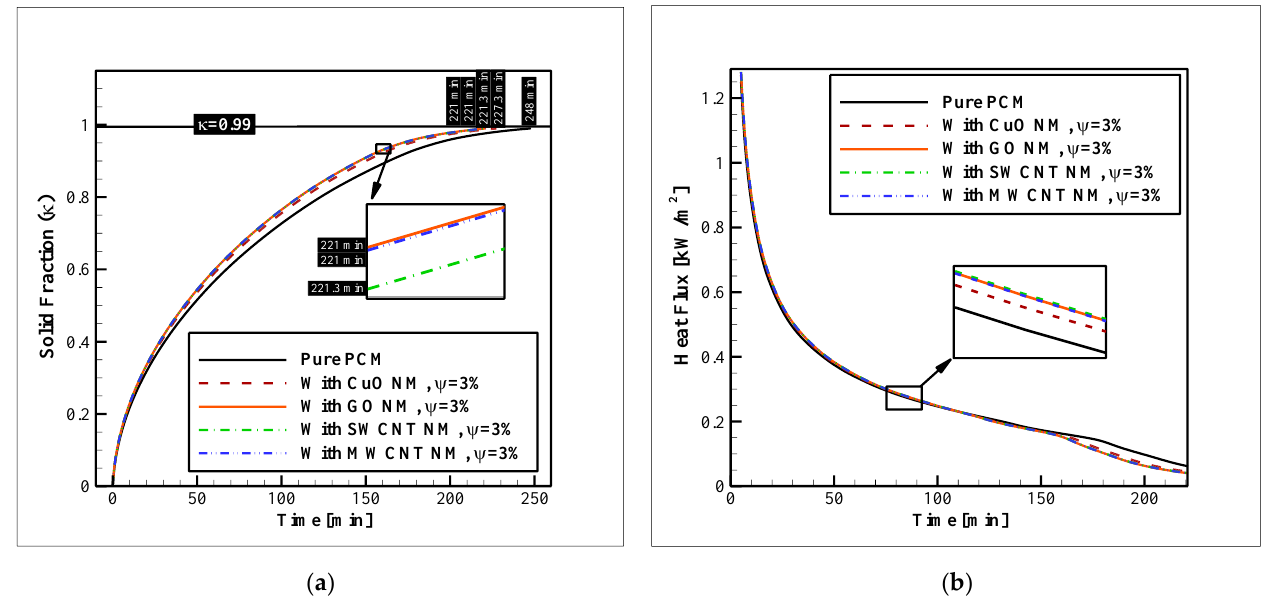
Figure 8. The influence of NM type at identical NM volume fractions on ( a ) progression of the average solid fraction; and ( b ) the heat flux passing through the refrigerant tubes.